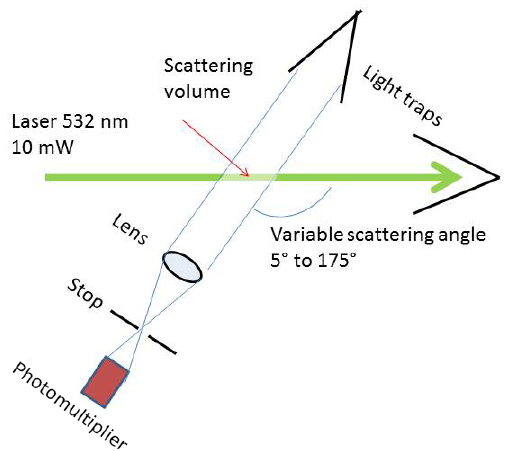
Figure 2. Principle of the polar